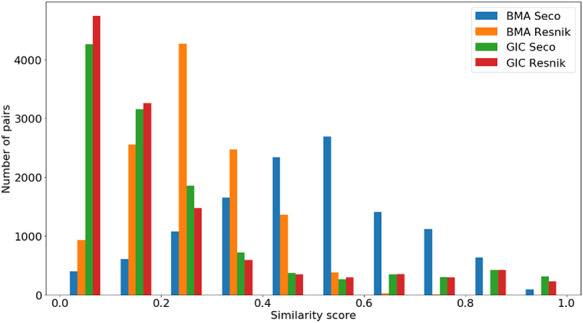
Distribution of all semantic similarity metrics (\documentclass[12pt]{minimal}
\usepackage{amsmath}
\usepackage{wasysym}
\usepackage{amsfonts}
\usepackage{amssymb}
\usepackage{amsbsy}
\usepackage{upgreek}
\usepackage{mathrsfs}
\setlength{\oddsidemargin}{-69pt}
\begin{document}
}{}$BM{A_{Resnik}}$\end{document}, \documentclass[12pt]{minimal}
\usepackage{amsmath}
\usepackage{wasysym}
\usepackage{amsfonts}
\usepackage{amssymb}
\usepackage{amsbsy}
\usepackage{upgreek}
\usepackage{mathrsfs}
\setlength{\oddsidemargin}{-69pt}
\begin{document}
}{}$BM{A_{Seco}}$\end{document}, \documentclass[12pt]{minimal}
\usepackage{amsmath}
\usepackage{wasysym}
\usepackage{amsfonts}
\usepackage{amssymb}
\usepackage{amsbsy}
\usepackage{upgreek}
\usepackage{mathrsfs}
\setlength{\oddsidemargin}{-69pt}
\begin{document}
}{}$simGI{C_{Resnik}}$\end{document} and \documentclass[12pt]{minimal}
\usepackage{amsmath}
\usepackage{wasysym}
\usepackage{amsfonts}
\usepackage{amssymb}
\usepackage{amsbsy}
\usepackage{upgreek}
\usepackage{mathrsfs}
\setlength{\oddsidemargin}{-69pt}
\begin{document}
}{}$simGI{C_{Seco}}$\end{document}) values across all species’ protein pairs in the gene-phenotypes data sets.